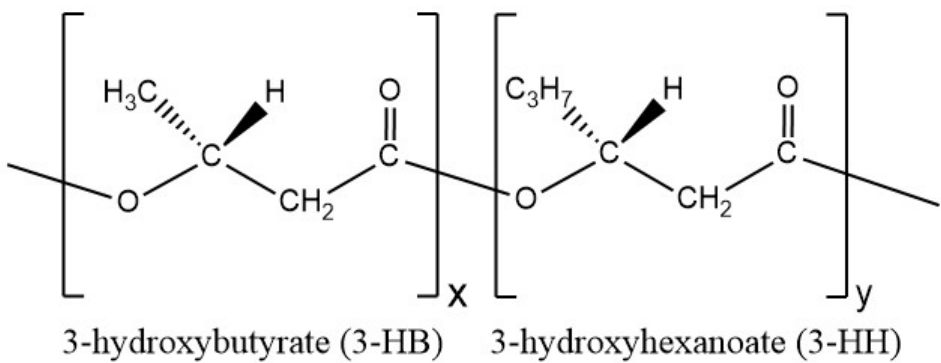
Figure 1. Chemical structure of poly(3-hydroxybutyrate-co-3-hydroxyhexanoate) (PHBH). Numerous thermoplastic processing techniques (e.g., extrusion, injection moulding, melt-spinning) have been applied in the past, and the polymer PHBH was formed into films, coatings, and fibers [16–19]. The melt-spinning technique is the most cost-effective method to produce fibers, due to a simple, solvent-free production line and a high production rate [20]. PHBH has a relatively low glass transition temperature (about 0 ◦ C) as well as a relatively low melting point (about 145 ◦ C). Melt spinning of PHBH is quite challenging due to its slow crystallization rate and low thermal stability [12,21]. There are only a few studies that discuss the interplay between the structural and mechanical properties of PHBH fibers melt-spun at the laboratory scale. These articles mainly focus on enhancing tensile properties by making specific modifications to the spinning line [19,21–24]. Most authors have quenched PHBH into an ice water bath to hinder secondary crystallization, followed by various post-drawing techniques [19,22,24]. The thus produced fibers had rather large diameters (several 100 µ m), and the reported tensile strengths were mostly rather low (<100 MPa). Kabe et al. [22] could achieve fibers with higher tensile strengths up to 552 MPa using a two-step drawing technique with intermediate annealing conditions, starting from PHBH with 5.5 mol% of the 3HH unit. Wide-angle X-ray diffraction (WAXD) measurements have revealed that the PHBH fibers with high tensile strength had a high contribution of mesophase, which gave rise to a broad reflection on the equator in WAXD patterns [7,25]. This mesophase also exists in highly drawn P3HB fibers [26–29], and its exact structure has been a matter of debate. Many authors have called this phase the β -form phase, where the chains are thought to have a zigzag conformation. A crystalline structure should however give rise to many additional off-axis reflections in the WAXD patterns, which in reality are missing. We therefore believe that the mesophase in PHBH fibers is, as in other fibers [26], made of highly oriented but conformationally disordered (tie-)chains between α -form crystals. Thus, in analogy to the mesophase in P3HB, we call this phase a highly oriented non-crystalline phase, P nc . Qin et al. [21] have produced PHBH filaments with a high-speed (take-up speed of 6 km/min) melt-spinning method, where the filaments reached tensile strengths of up to 156 MPa. In this study, the crystalline orientation of α -form crystals increased with an increase in the take-up godet speed and the existence of a small amount of mesophase was detected at high take-up speeds. The mechanical properties of the PHBH fibers could be improved (tensile strength of 215